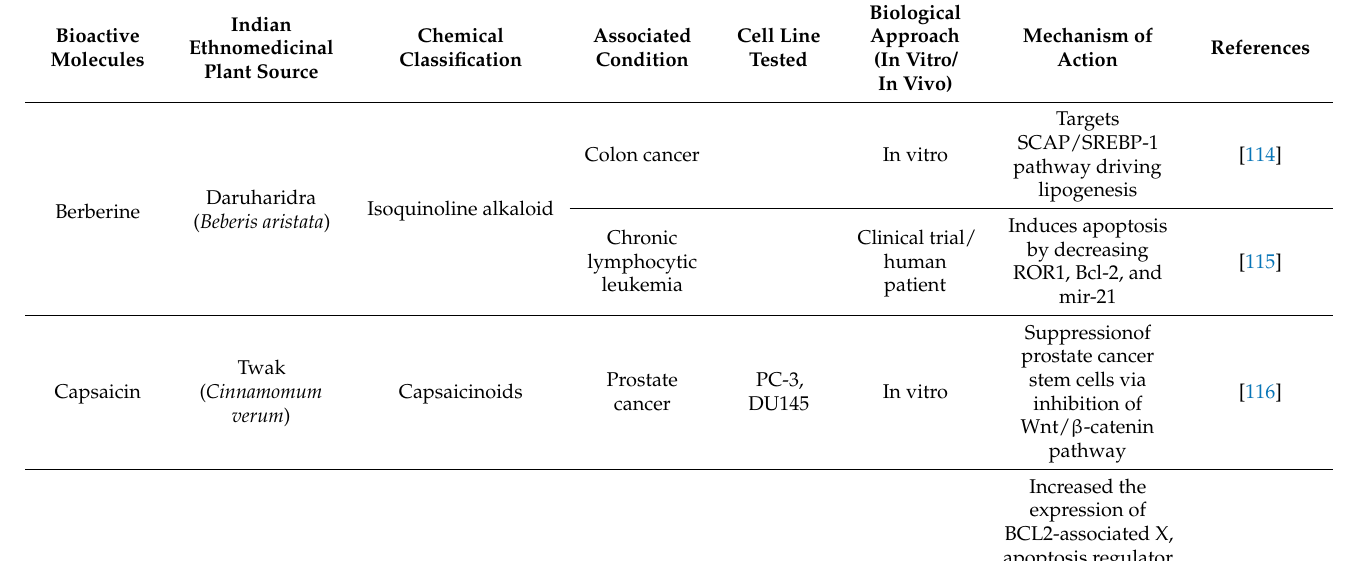
Table 4. Anticancer activity of some potent antioxidant alkaloids (recent